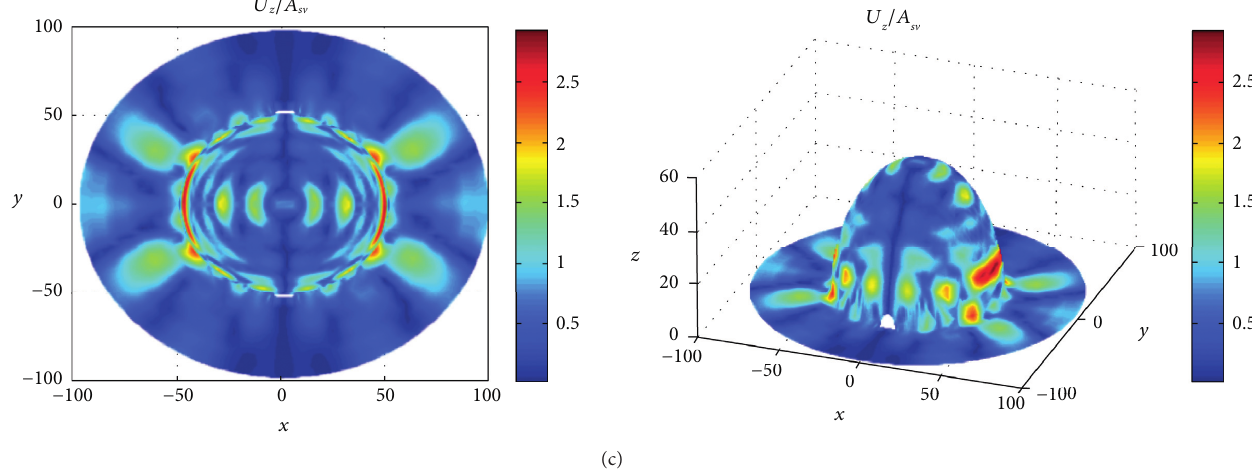
Figure 14: Surface displacement amplitude of the 3D tunnel mountain under the incident SV wave ( η � 5 . 0 , α � 0 ° ): (a) surface dis- placement amplitude in x direction; (b) surface displacement amplitude in y direction; (c) surface displacement amplitude in z